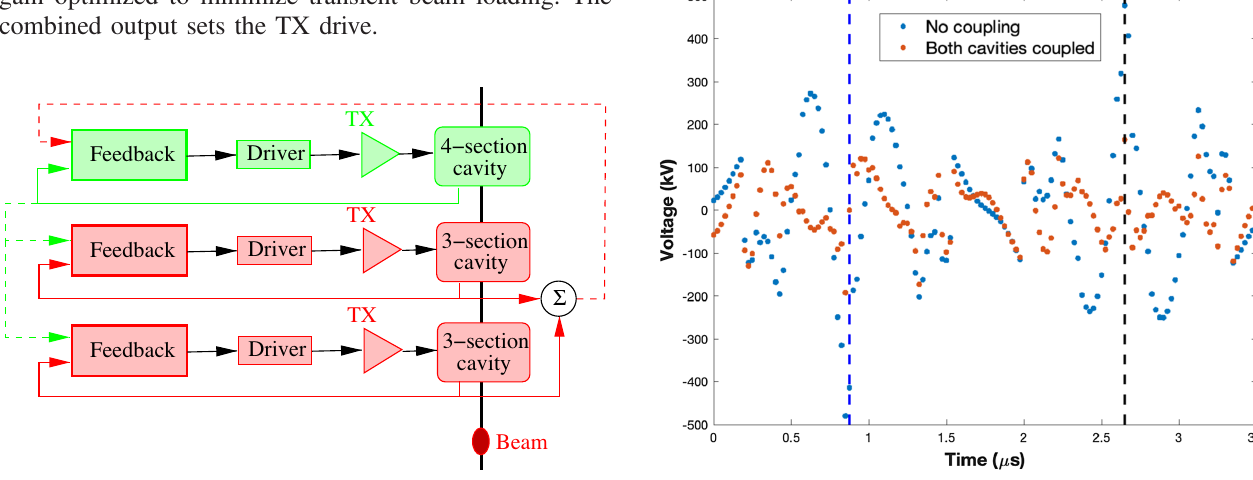
FIG. 15. Uncompensated beam loading with coupled feedback. The feedforward is also on. The batch is indicated with vertical dashed